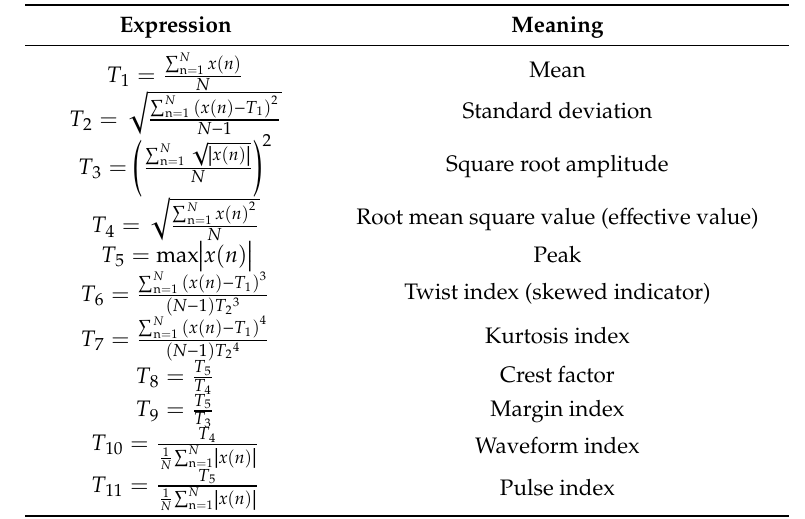
Table 1. Time domain feature